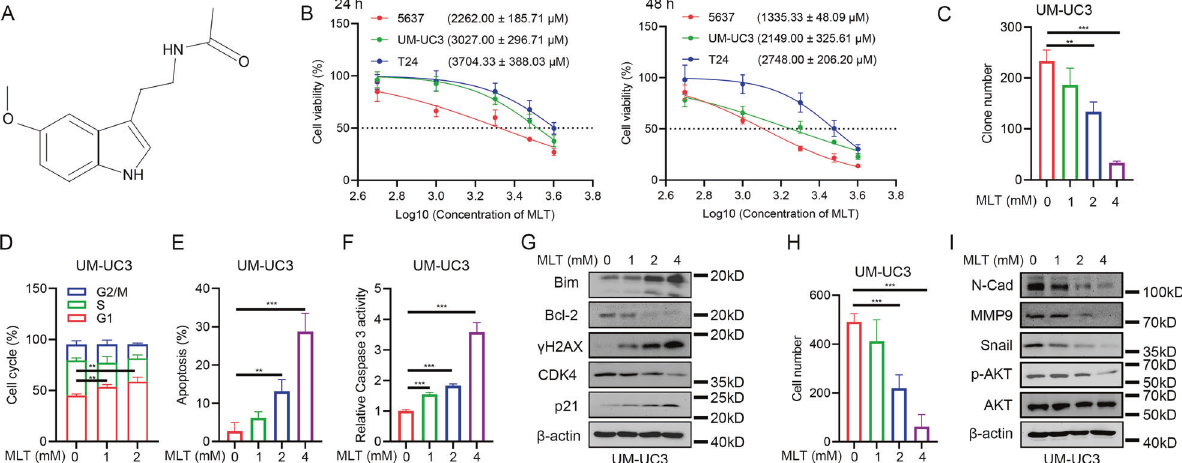
Fig. 1 Melatonin exerted inhibitory effects on proliferation and metastasis of BLCA cells. A Structural of melatonin. B IC50 value of 24 h and 48 h melatonin treatment on BLCA cells ( n = 3). C Statistical analysis of clone formation assay of UM-UC3 cells under 48 h melatonin treatment ( n = 3). D Statistical analysis of cell cycle distribution of UM-UC3 cells under 24 h melatonin treatment ( n = 3). E Statistical analysis of apoptotic cells of UM-UC3 cells under 24 h melatonin treatment ( n = 3). F Caspase 3 activity assay of UM-UC3 cells under 24 h melatonin treatment ( n = 3). G Western blot assay of apoptosis-related and cell cycle-related proteins of UM-UC3 cells after 24 h melatonin treatment. H Transwell assay of UM-UC3 cells after 24 h melatonin treatment and statistical analysis. I Western blot assay of EMT-related proteins cells after 24 h melatonin treatment. * p < 0.05, ** p < 0.01, *** p <